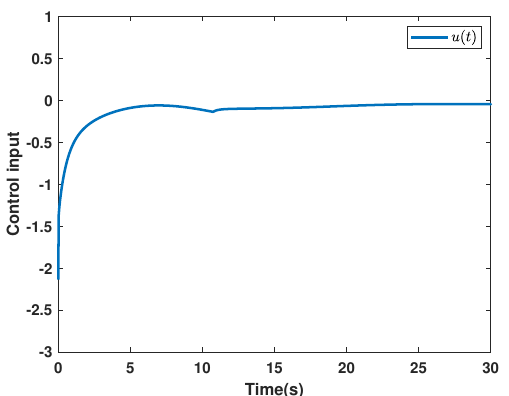
Figure 5. Adaptive SMC law u ( t )